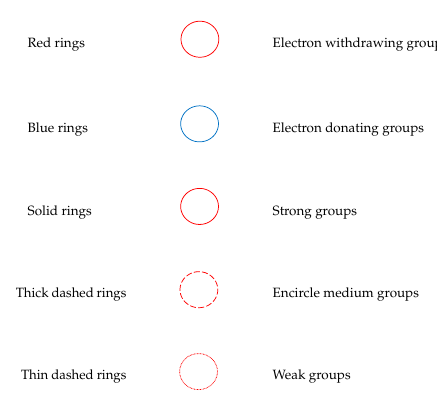
Microorganisms 2020 , 8 , x FOR PEER REVIEW